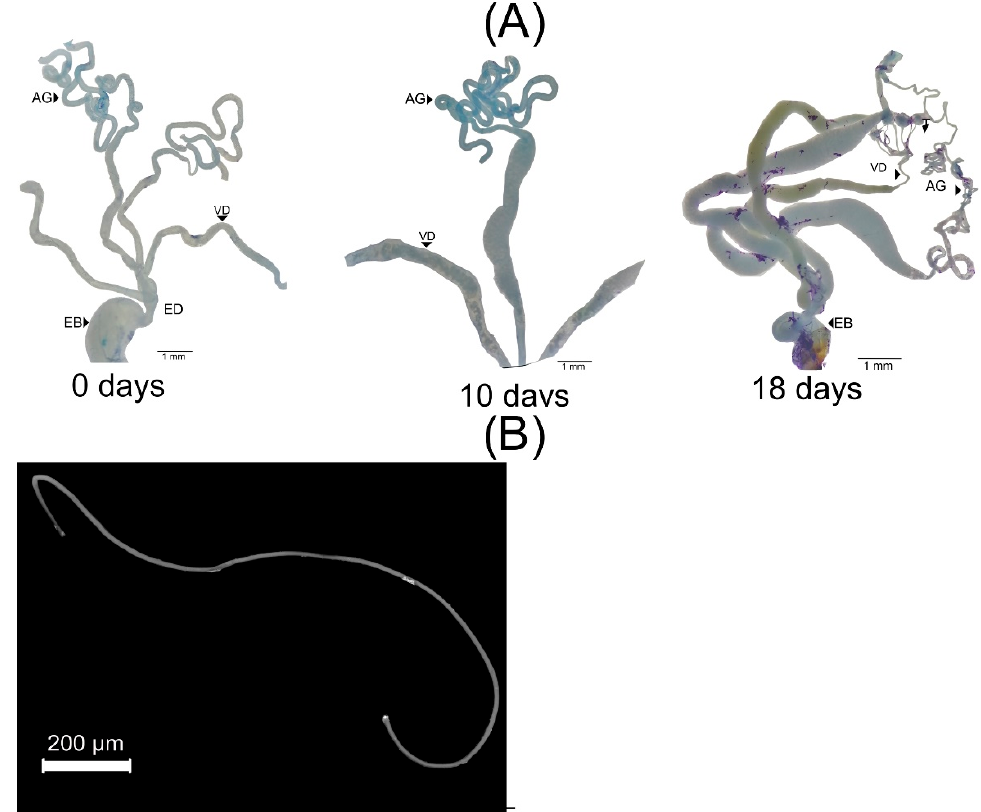
Figure 4. Development of male reproductive apparatus and sperm of Cyclocephala barrerai : ( A ) de- velopment through time, ( B ) sperm from an 18 d old male. AG = accessory glands, Vd = vasa def- ferentia, ED = ejaculatory duct, EB = ejaculatory bulb. When males are 18 d old, the distal section of the accessory glands are filled with a white content, and the mature sperm is in the proximal portion of the vasa deferentia. Mature sperm has a filamentary shape (Figure 4B).